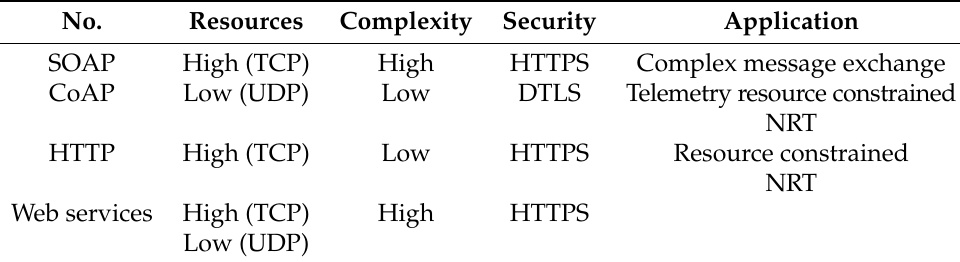
Table 5. Comparison of messaging/transport technologies.